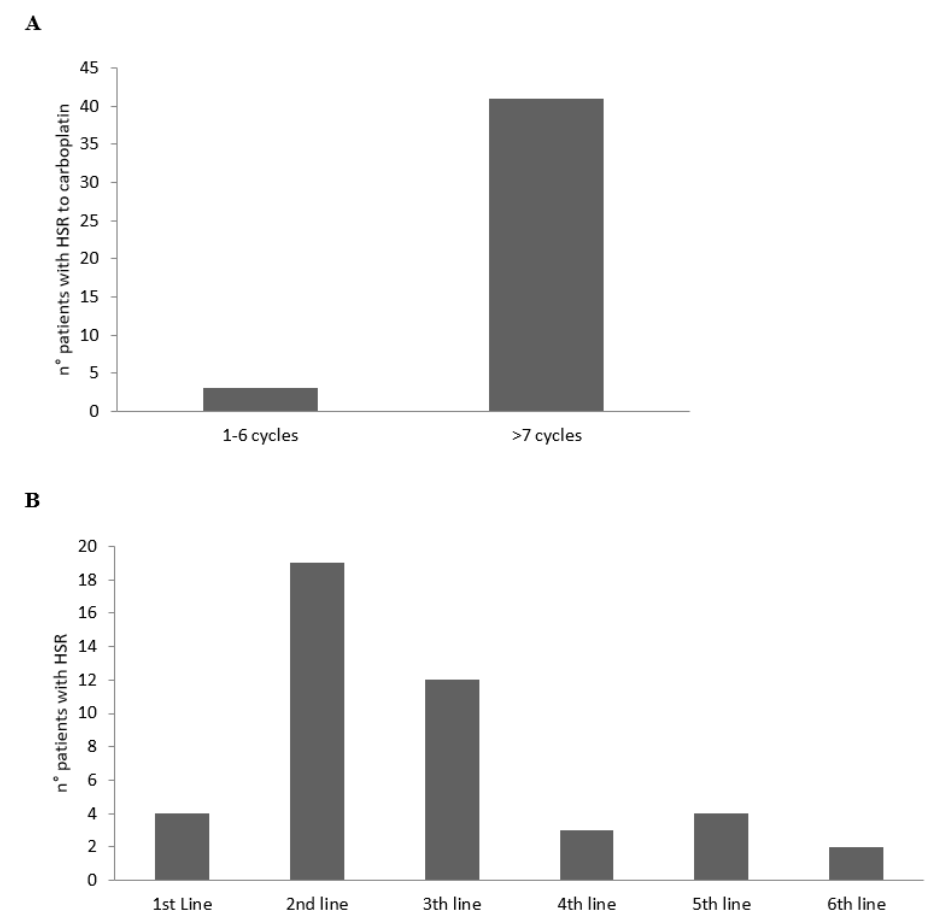
Figure 1. Number of patients with HSRs to CBDCA according to the cycles ( A ) and lines ( B ) of therapy.